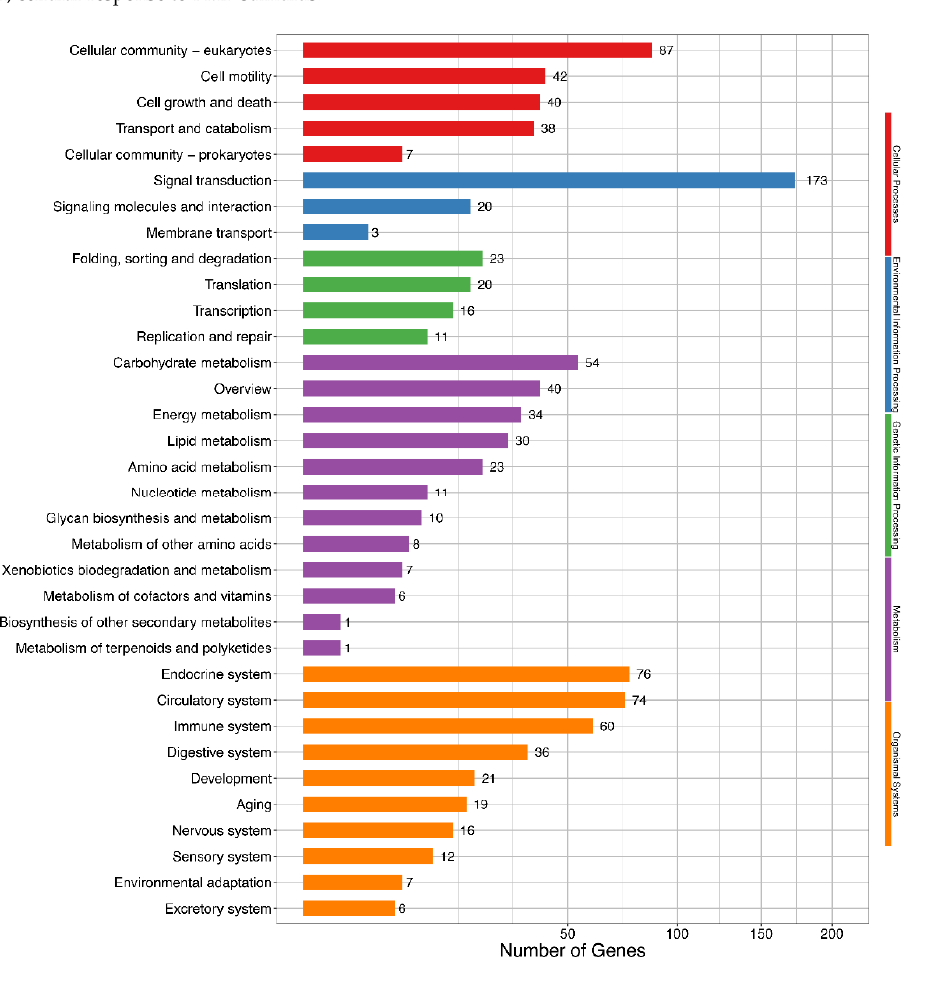
Figure 4. Kyoto Encyclopedia of Genes and Genomes (KEGG) enrichment of differentially expressed isoforms. Hyper-geometric distribution method is used. FDR ≤ 0.05 is considered as significantly enriched.